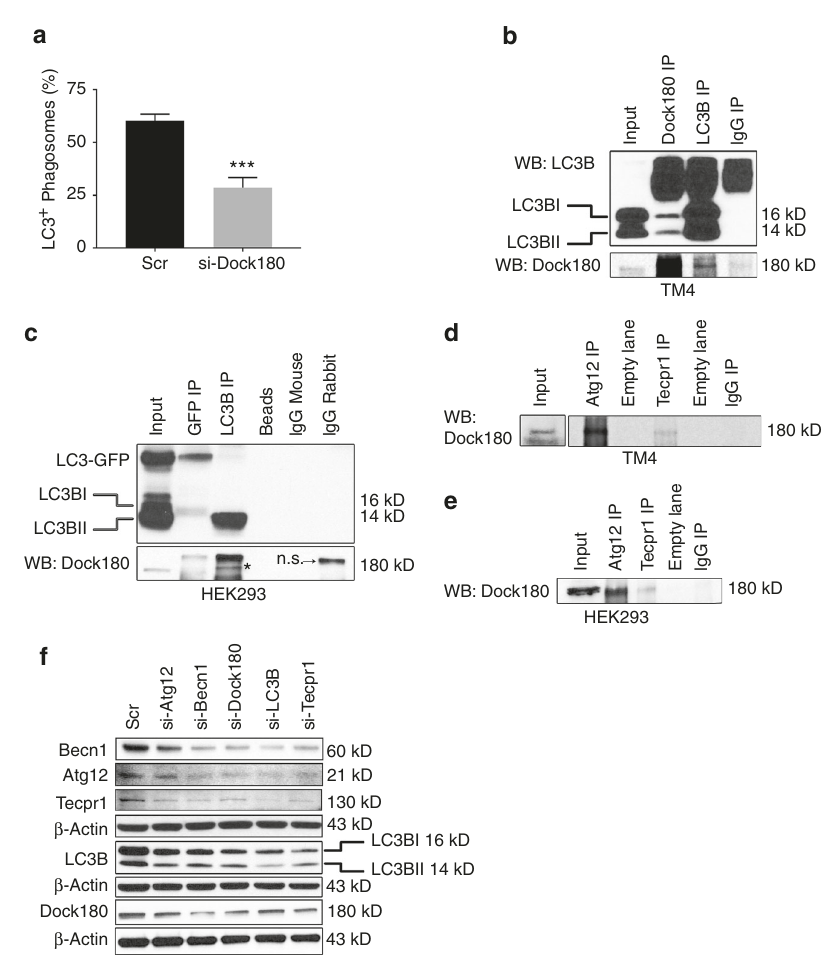
Fig. 5 Dock180 interacts with LC3B and other autophagy-associated proteins to regulate LAP in Sertoli cells. a The percentage of LC3 + phagosomes containing apoptotic germ cells in scramble-siRNA or Dock180-siRNA transfected Sertoli cells as obtained from immuno fl uorescence analysis. The data represent mean ± SEM of three independent experiments ( n = 100 per group), *** p = 0.0006, two-tailed unpaired student t -test. b , c Dock180 interacts with LC3 in mammalian cells. Immunoprecipitation on TM4 cells ( b ) or HEK293 cells ( c ) using antibodies against Dock180 (Dock180 IP), LC3B (LC3B IP), GFP (GFP IP), rabbit IgG (IgG IP) or mouse IgG (IgG mouse) ( c ) and probed (WB) with LC3B or Dock180 antibodies. For c , cells were transfected with GFP- LC3B-RFP expression construct before being subjected to immunoprecipitation. Immunoprecipitation with beads alone (Beads) served as a negative control. Asterisk in c indicates Dock180 band. n.s represents ‘ non-speci fi c ’ band. d , e Immunoprecipitation on TM4 ( d ) and HEK293 ( e ) using antibodies against Atg12 (Atg12 IP) or Tecpr1 (Tecpr1 IP) or rabbit IgG (IgG IP) and probed with Dock180 antibody. f Western blot analysis on TM4 Sertoli cells transfected with scramble (Scr) siRNA or siRNAs (si) against autophagy associated proteins Becn1 (si-Becn1), Atg12 (si-Atg12), Tecpr1 (si-Tecpr1), and LC3B (si-LC3B) using antibody against indicated autophagy proteins. β -Actin served as a loading control. Gel photograph is representative of four independent experiments. Bar graphs showing quanti fi cation of band intensities are shown in Supplementary Fig.